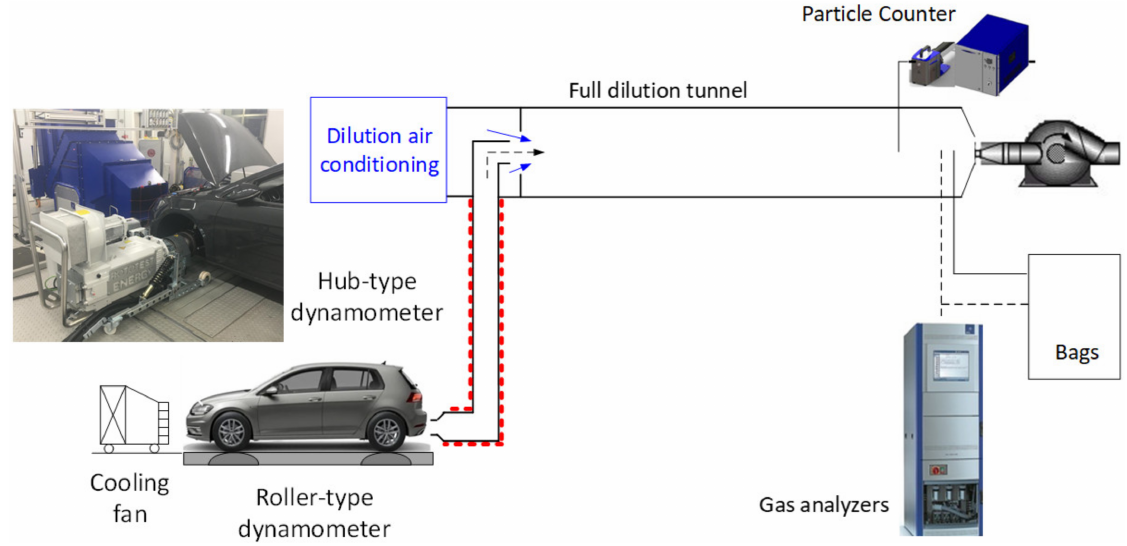
Figure 1. Experimental